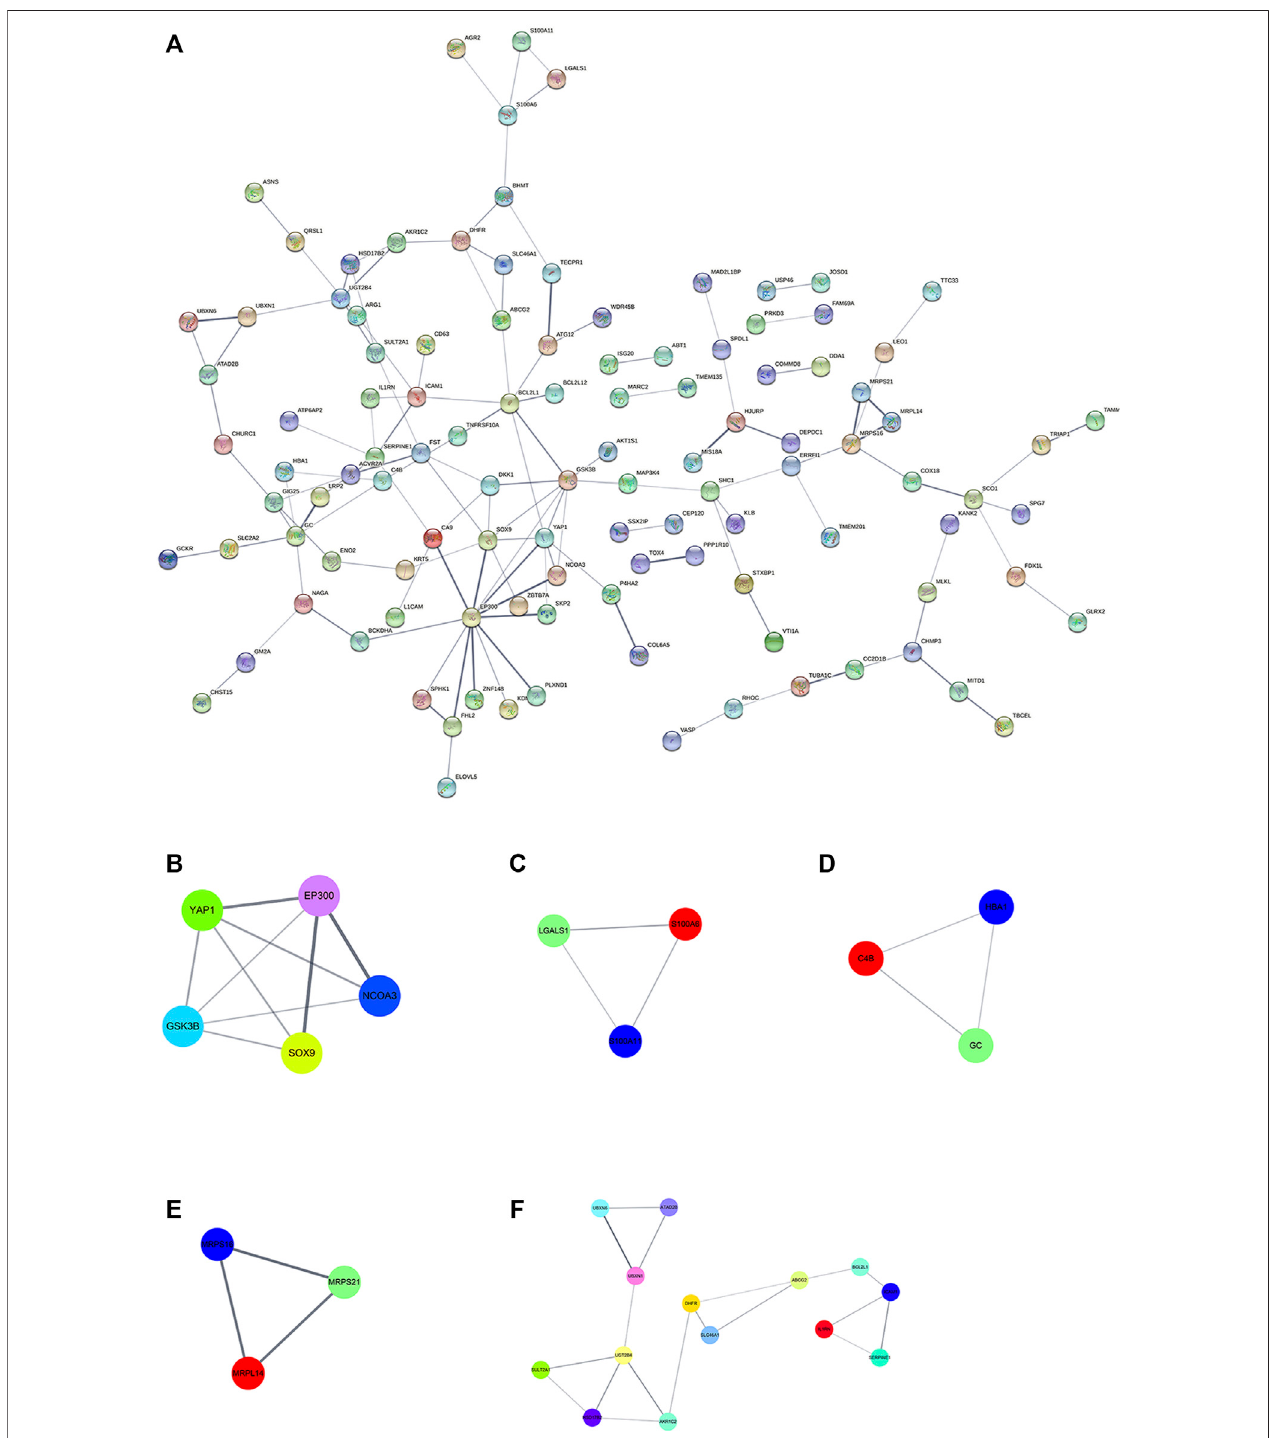
FIGURE 6 | PPI network and module analysis (A) PPI network for DEPs; (B) critical module one in PPI network (C) critical module two in PPI network; (D) critical module three in PPI network (E) critical module four in PPI network; (F) critical module fi ve in PPI network. Different colored lines represent different evidences. The straight line (edge) represents the interaction between proteins. The thicker the line, the stronger the interaction between them.